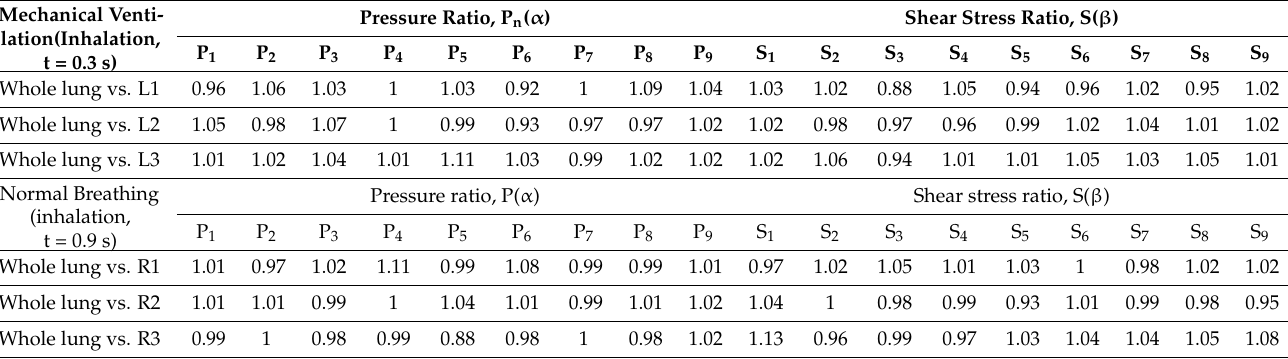
Table 2. Ratio, α and β of pressure and shear stress at selected 9 points in Figure 12 in whole lung (left and right) and isolated local bifurcations (L1, L2, L3, R1, R2, R3). P n ( α ) = pressure of selected point in whole lung/pressure of selected point in local bifurcation, n = 1,2,3,4,5,6,7,8,9), S n ( β ) = shear stress of selected point in whole lung/shear stress of selected point in local bifurcation, n = 1,2,3,4,5,6,7,8,9). Mechanical Venti- lation(Inhalation, t = 0.3